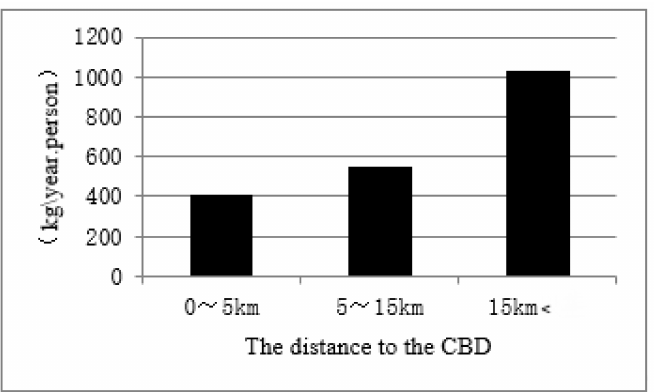
Figure 2. Travel carbon emissions of residents with different distances from community to